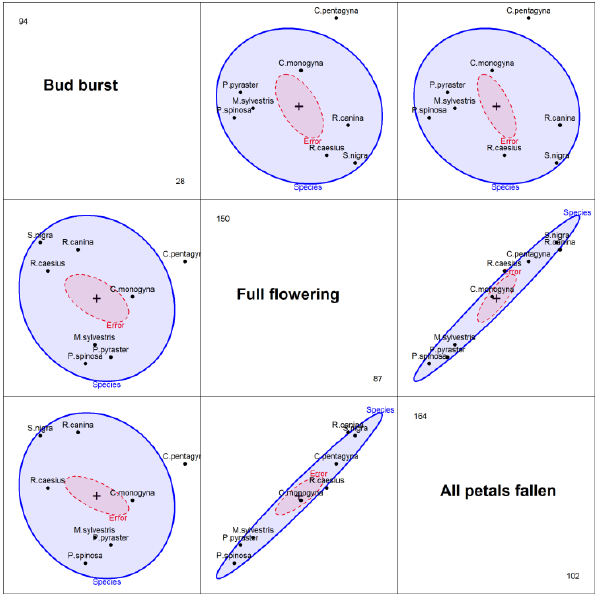
Figure 2. Distribution of species and averages of those distributions by pairs of variables. As observed in Table 2, the first axis (LD1) explains most of the variation (0.829). Based on the value of correlation coefficients for the first canonical axis, “all petals fallen” (0.273) and “bud burst” (0.138) are the most important variables in discriminating/separating groups of species. “Bud burst” is the most important variable in relation to the second axis (0.122), and “full flowering” is the most important variable in relation to the third axis (0.269), and this is also visible in Figure 3.